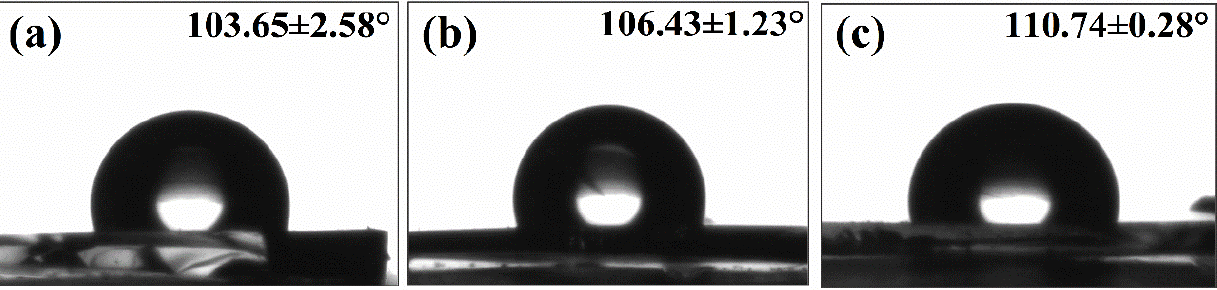
Figure 6. Static contact angles of water of CPBCS3-1, CPBCS5-1, and CPBCS10-1 polymers solids.